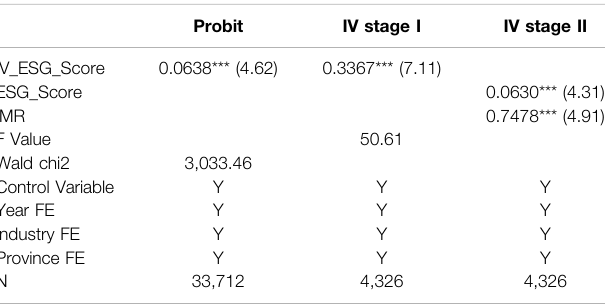
TABLE 6 | IV Regression results (ESG overall